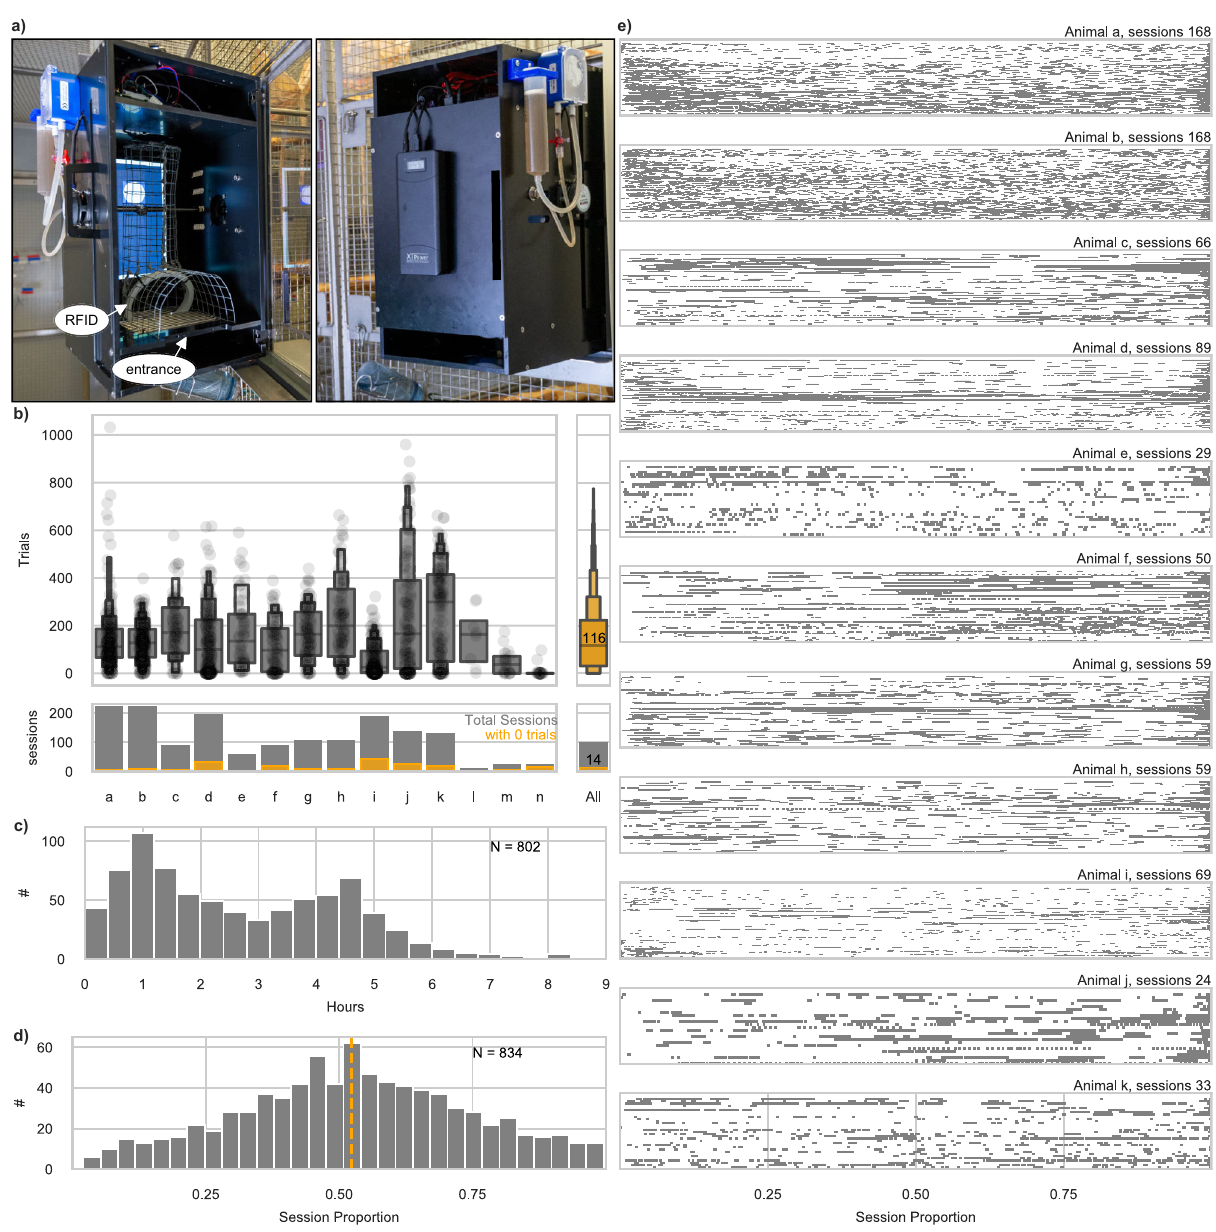
Fig. 1 General engagement on the MXBI across all autonomous experiments. a MXBI device attached to a cage in the animal facility. Left — opened for experimenter access to the inside of the device, Right — closed. b Letter-value plots of the number of trials performed in each session, dark gray: for each animal individually, orange: average distribution with all animals considered. The central box de fi nes the median and 25th up to 75th percentile. Successively narrower boxes are drawn between the 1/8*100th and 7/8*100th, the 1/16th and 15/16*100th, and so on percentile. The total number of trials per animal can be found in Table 1. The number of sessions per animal and the average across animals are plotted below. Sessions without a single trial performed are given in orange. c Distribution of the duration of all sessions. d Distribution of all median timestamps as a function of session proportion. The dashed orange line indicates that across sessions half of the trials were performed within 52% of the session duration. e For each of the animals with more than 3000 trials, each trial of each session with more than 10 interactions (shared ordinated) is plotted with respect to its timestamp normalized by the session train naive marmosets at their own pace on the basics of a 2AC visually guided task. In order to identify the appropriate para- meters upon which to build such autonomous procedure we fi rst designed and tested multiple AUT versions with a subset of 9 animals (described in supplementary tables S1 and S2). The resulting fi nal versions of the protocols (AUTs 8, 9, and 10), were then tested with 4 naïve animals (animals f, k, c, and d). The AUT procedure was comprised of 4 milestones — (1) decrease of the size of a visual stimulus (trigger) to be touched for reward, (2)